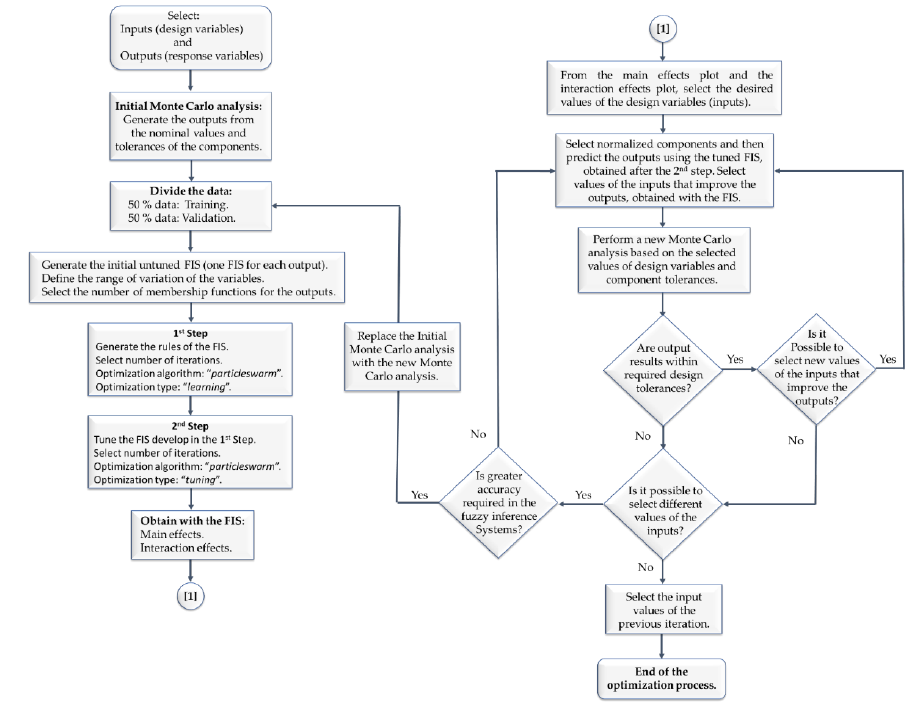
Figure 10. Scheme of the proposed method.